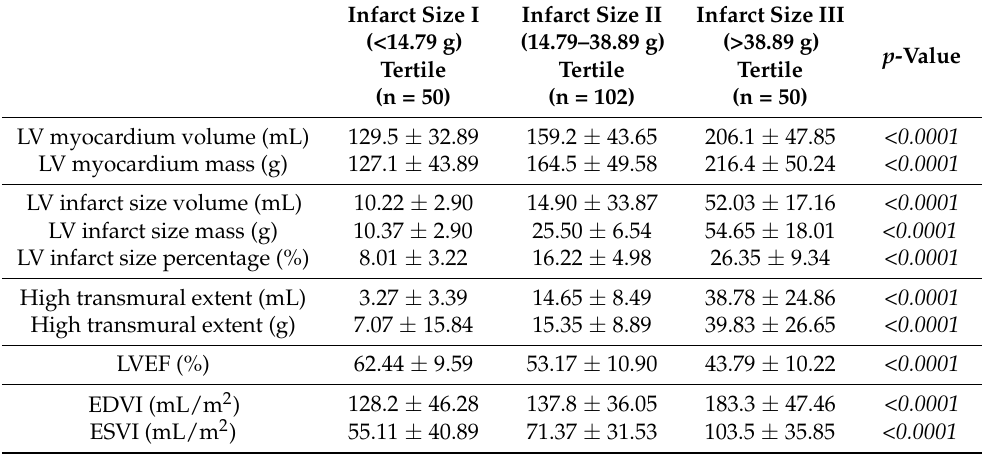
Table 4. CMR imaging parameters of the study